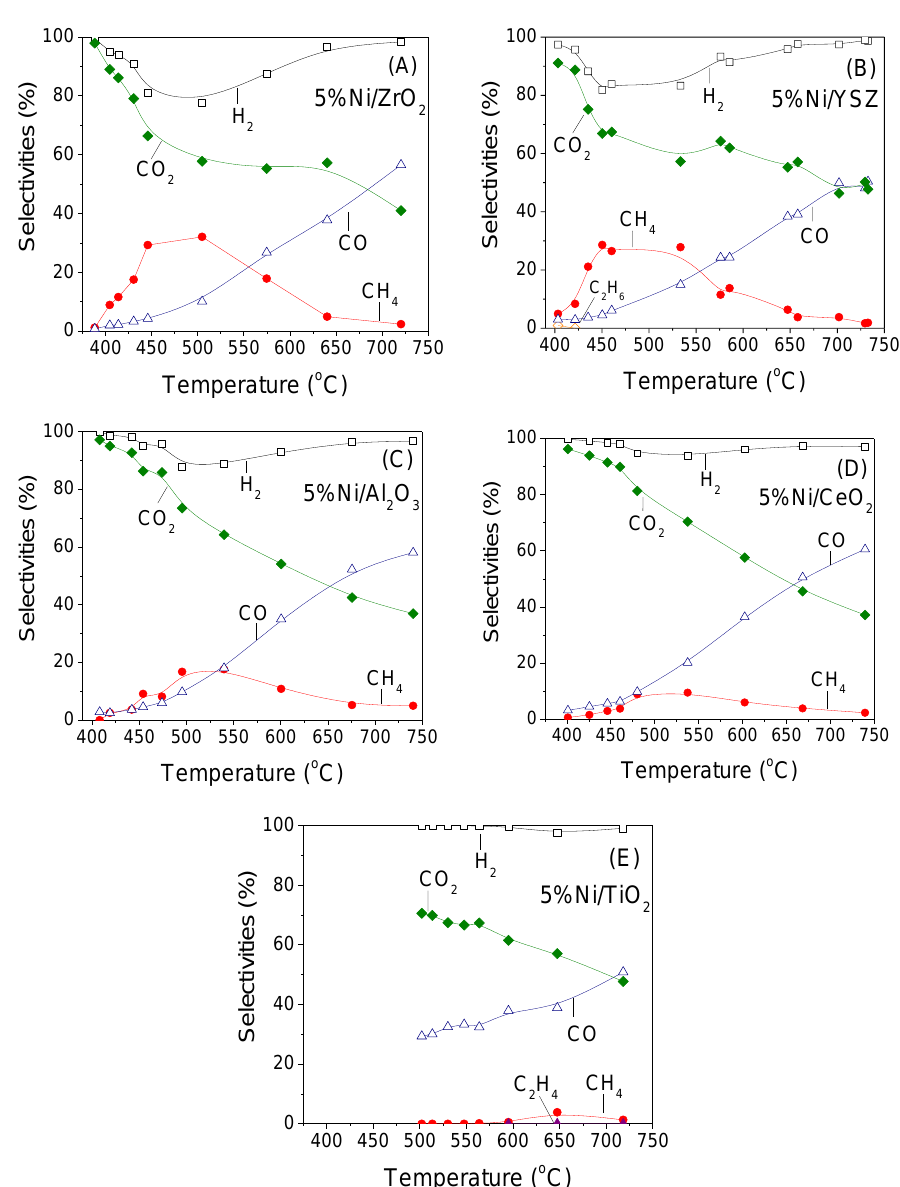
Figure 4. Selectivities toward reaction products as a function of reaction temperature obtained over Ni catalysts (5.0 wt.%) supported on ( A ) ZrO 2 , ( B ) YSZ, ( C ) Al 2 O 3 , ( D ) CeO 2 and ( E ) TiO 2 . Experimental conditions: same as in Figure 3.